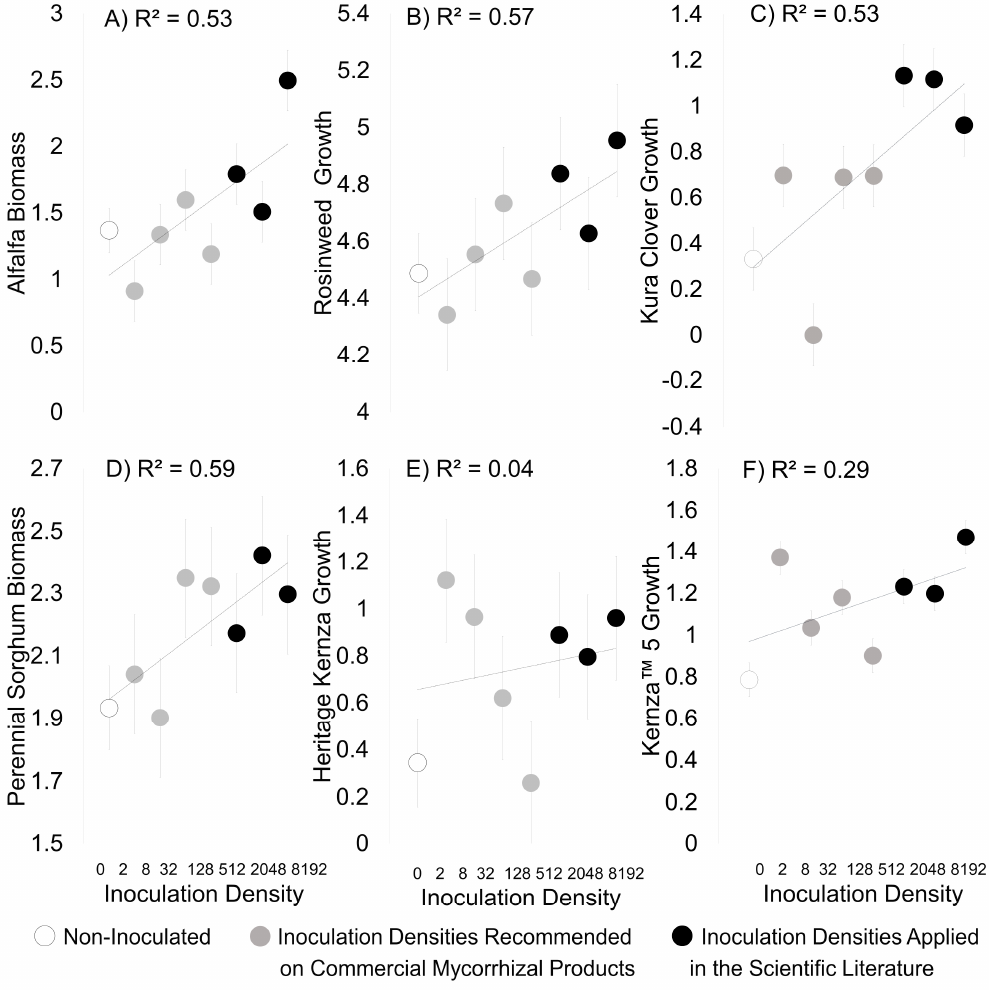
Figure 3. Plant growth in the field when plants were grown with no mycorrhizal inoculation (white, open circles ○ ), with densities of mycorrhizal amendment recommended by commercial producers if inoculum (grey circles (cid:8) ), and with mycorrhizal amendment densities that have been shown to be e ff ective in the scienti fi c literature (black circles ● ). The growth of some plants was positively improved ( A–D ) or generally unaffected ( E, F ) by mycorrhizal density. Dots represent the average plant size when plants were grown with each of the eight inoculation densities, error bars are standard error, and lines are best fit lines for plants that had a linear response relationship with inoculation density.